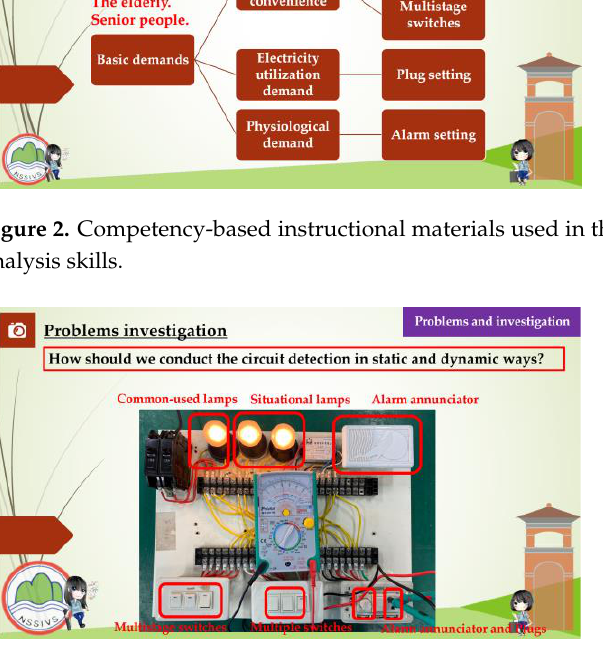
Figure 3. Competency-based instructional materials used in this research. This is the problem investigation.